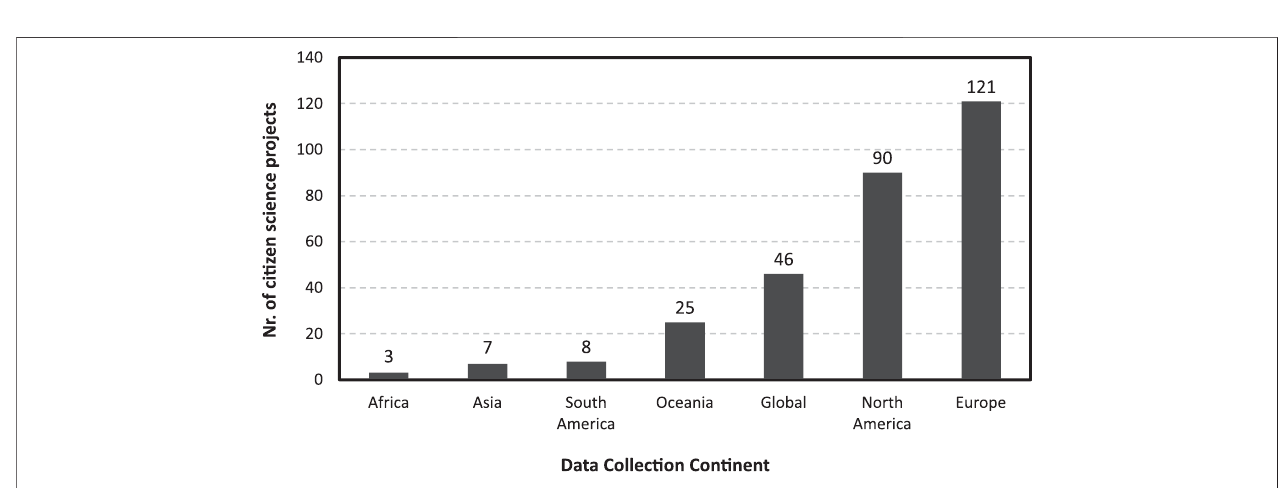
FIGURE 1 | Number of citizen science projects by continent where the data collection took place. Projects that collected data from more than one continent were classi fi ed as “ global. ”